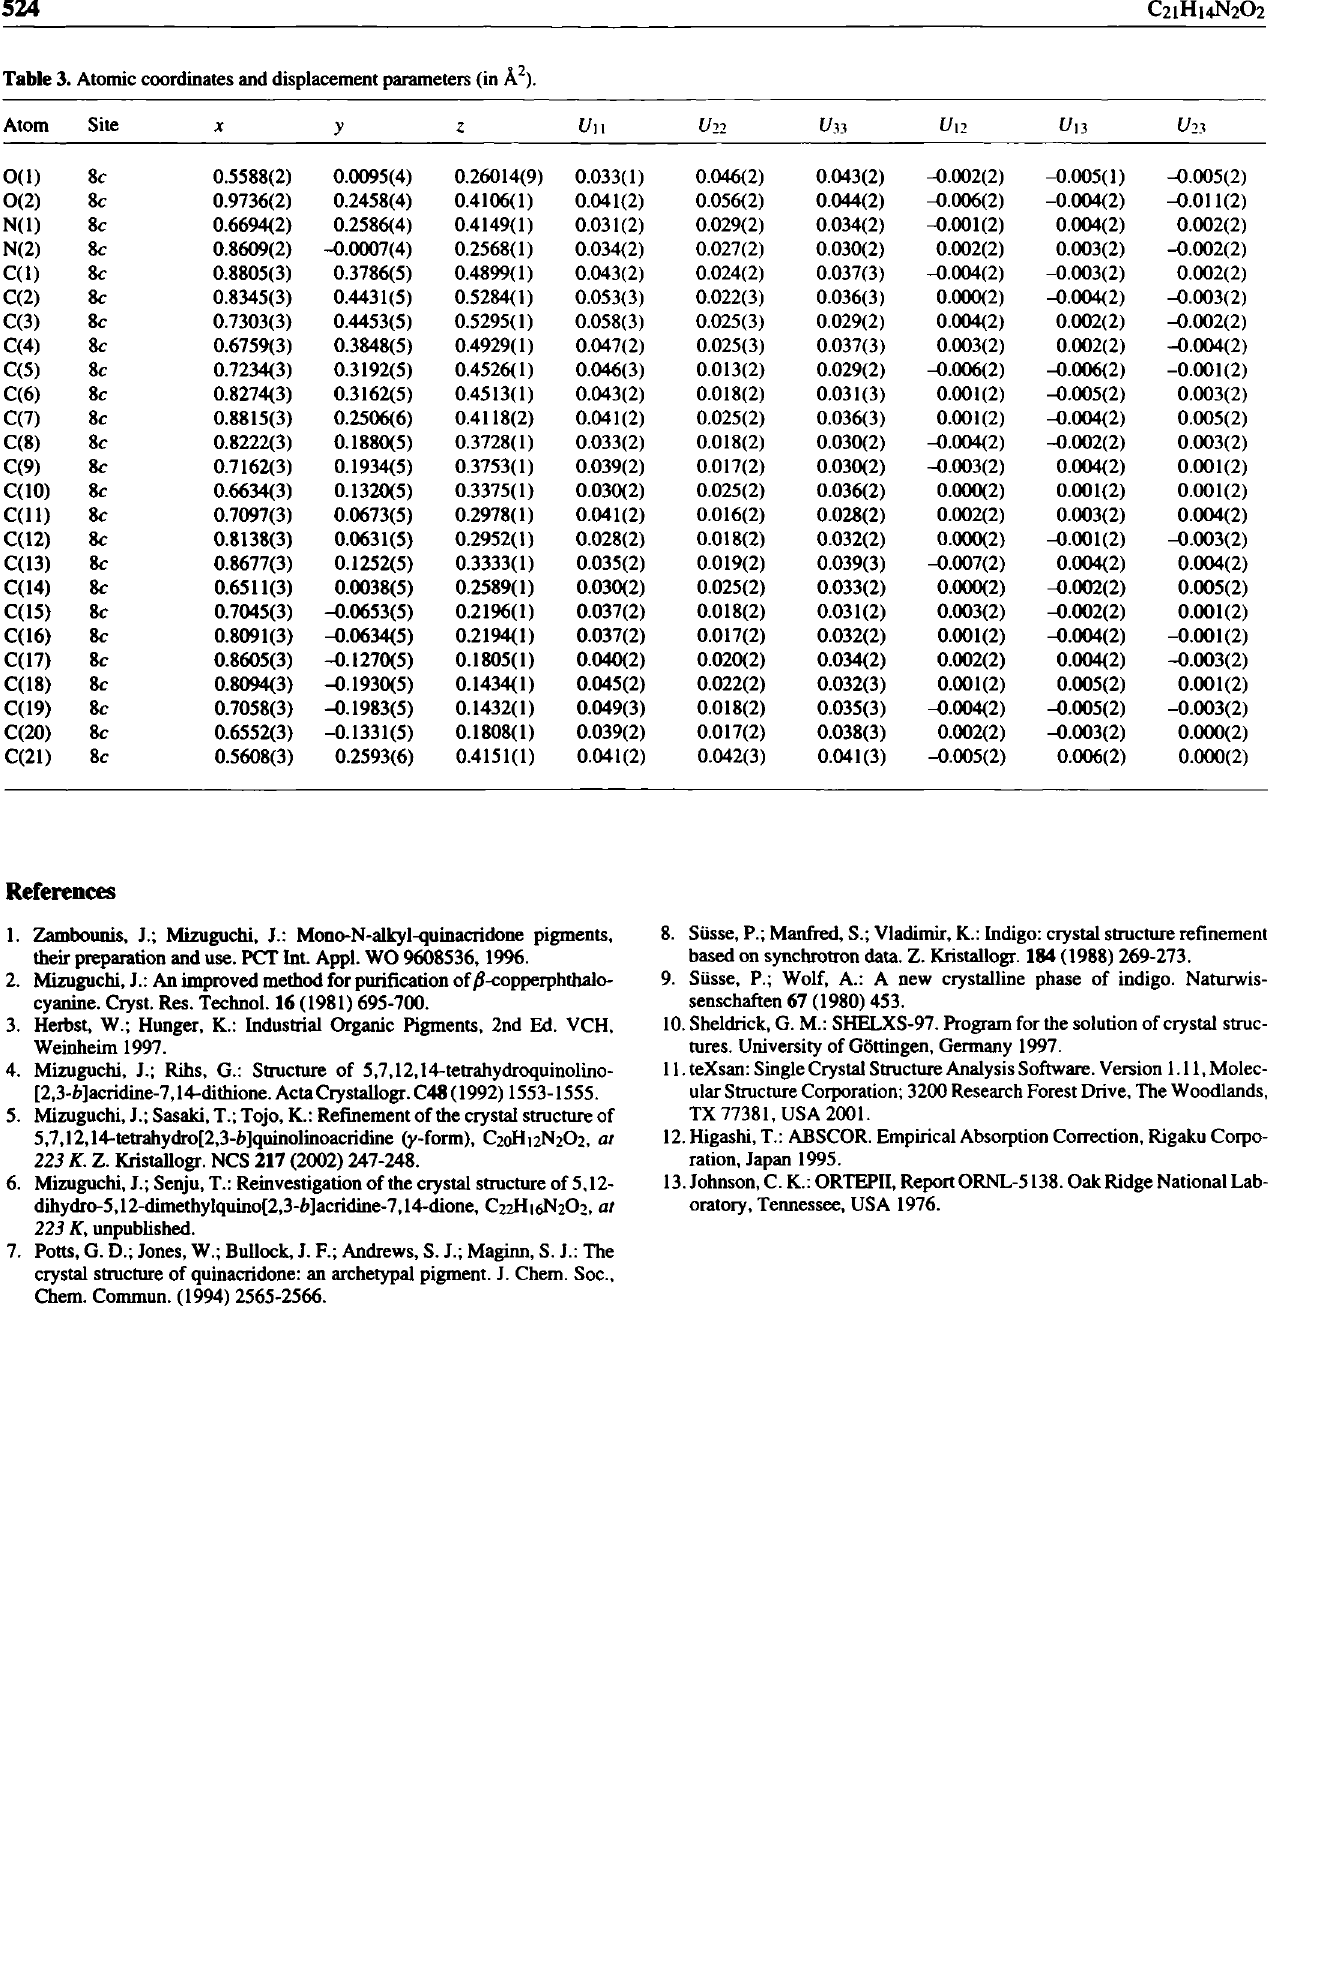
Table 3. Atomic coordinates and displacement parameters (in Ä 2